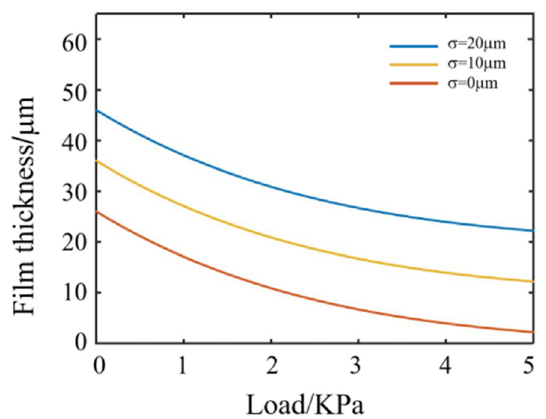
Figure 5. Influence of total load on liquid film thickness.